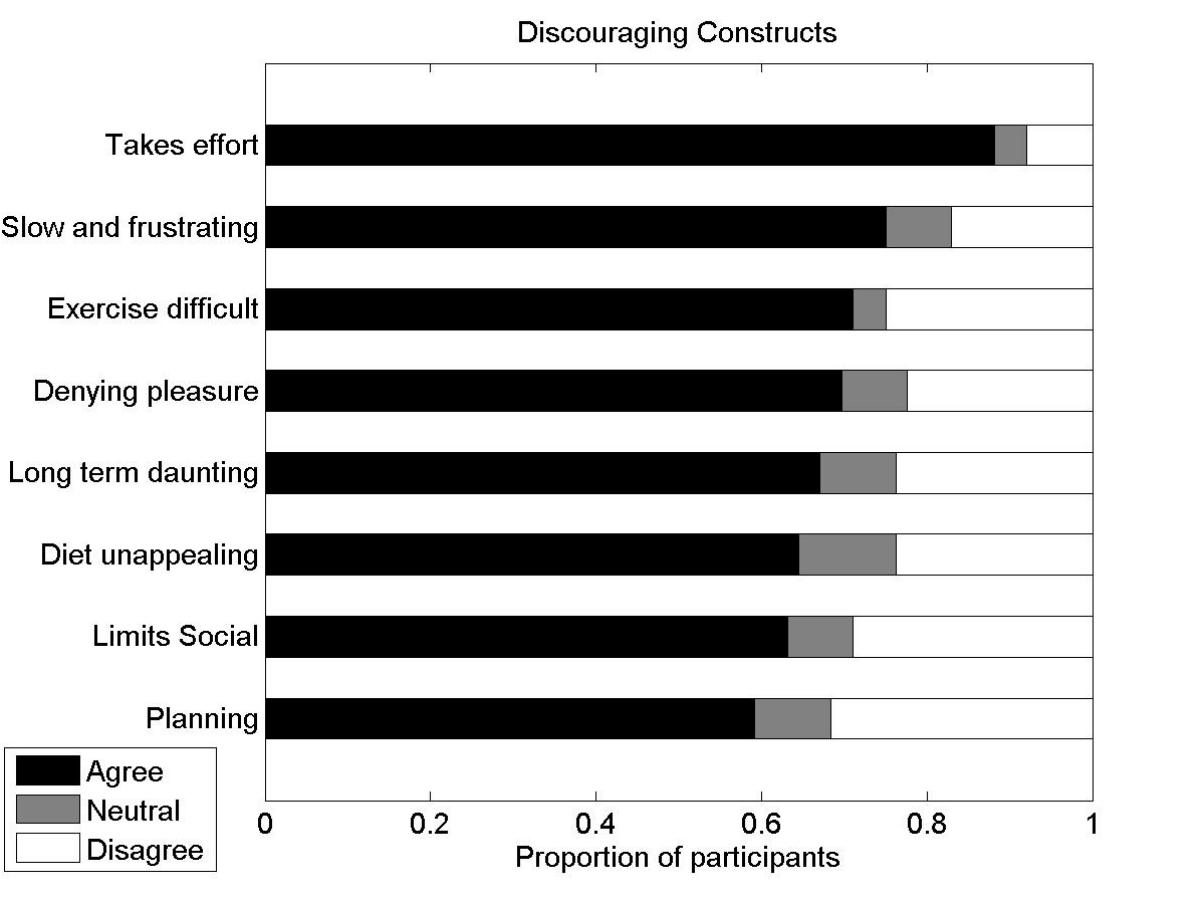
Figure 1. The proportion of respondents who agreed, were neutral, or disagreed with statements reflecting constructs that discouraged successful weight